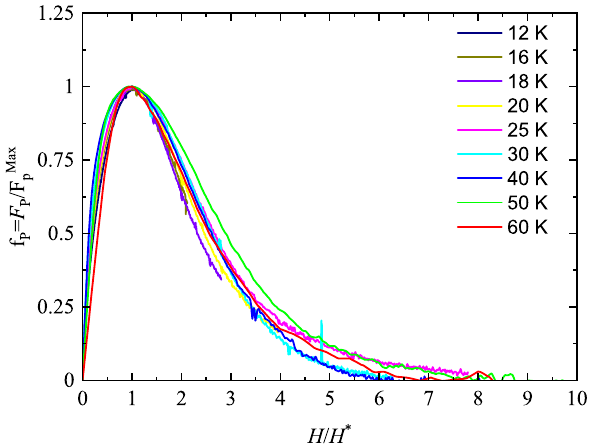
Figure 4. Reduced pinning force density f p = F p / F pmax as a function of the reduced field H / H *, at 60, 50, 40, 30, 25, 20, 16, 12